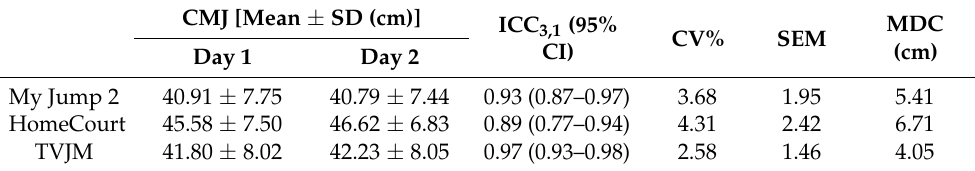
Table 4. Between-day test–retest reliability of CMJ measurement